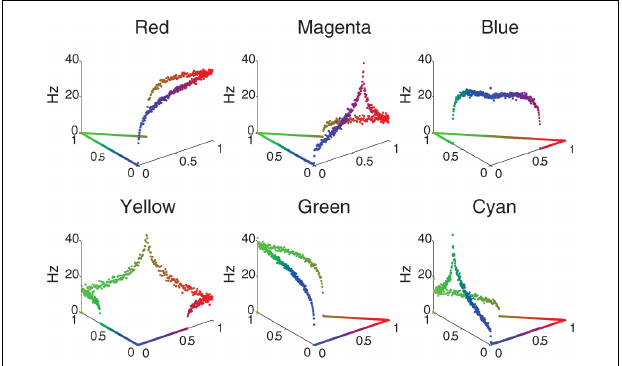
FIGURE 2 |V4 color selectivity. Shown are responses of six excitatoryV4 color units to a color stimulus cycling through all combinations of RGB (Red–Green–Blue) values that sum to a constant value of 1.The X - and Y -axes correspond to the color shown: the far left corner corresponds to pure green, the far right is pure red, and the near corner is pure blue.The Z axis represents the firing rate of the neuron in Hertz. One can clearly see that for example the Red unit (upper left tile) responds maximally to a pure red stimulus, and each unit responds maximally to its corresponding pure color.